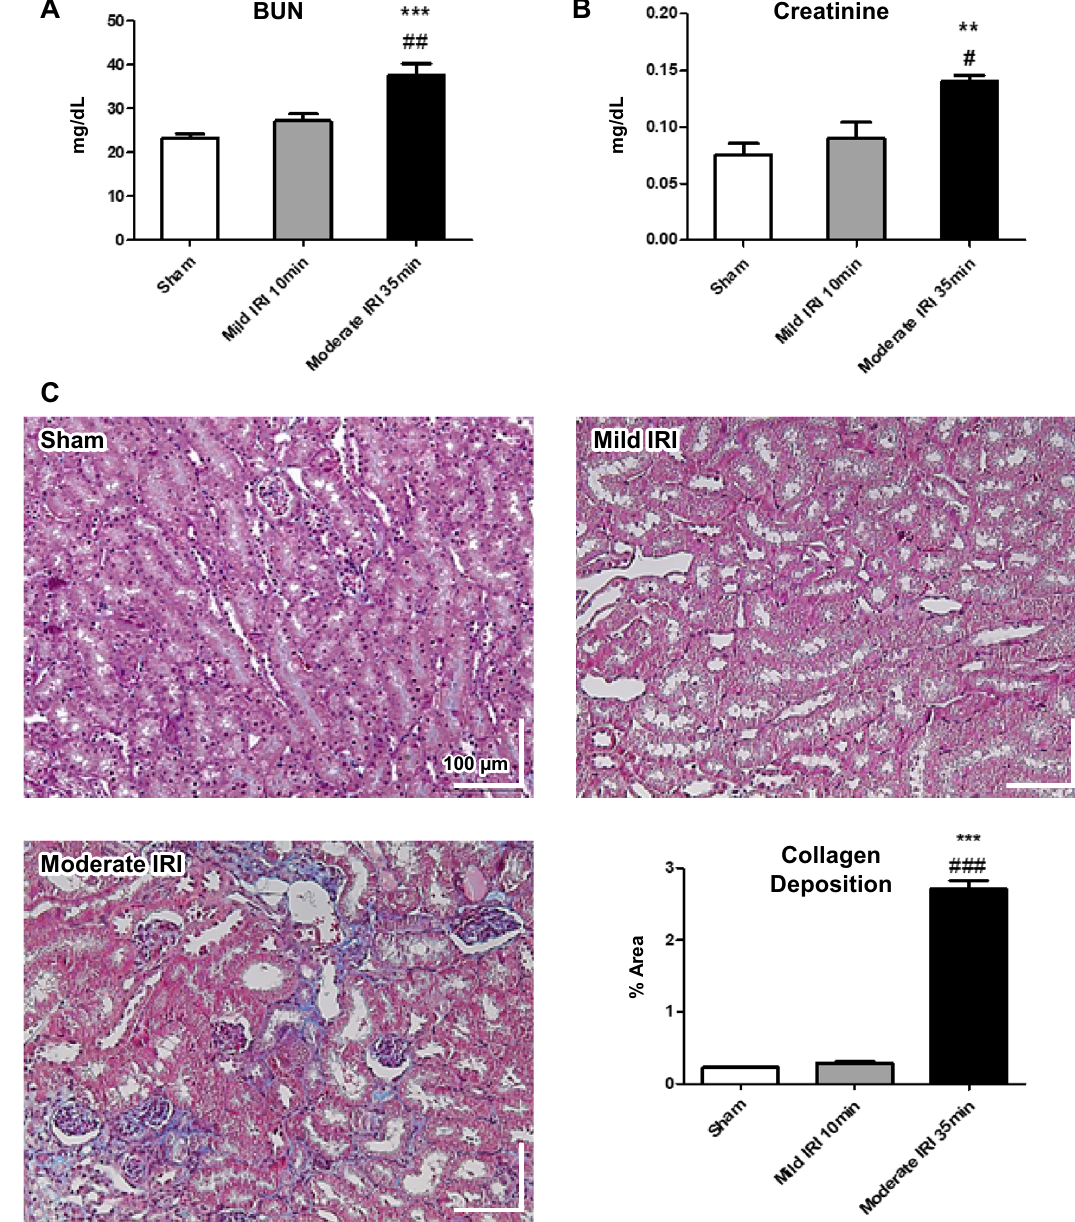
Figure 5. The kidney function and histological alteration in renal ischemia–reperfusion injury models 7 weeks after ischemia. ( A , B ) The levels of serum blood urea nitrogen (BUN) and creatinine were significantly increased in moderate IRI (35-min) group. ( C ) The trichrome-stained kidney sections (200×) and their quantifications showed tissue damage in renal tubular epithelial cells and increased collagen deposition in moderate IRI (35-min) group. Data represent mean ± SEM. * p < 0.05, ** p < 0.01 *** p < 0.001 vs. sham; # p < 0.05, ## p < 0.01, ### p < 0.001 vs. mild IRI (10-min). The differences among the groups were analyzed using one-way nonparametric ANOVA followed by Tukey’s multiple comparison